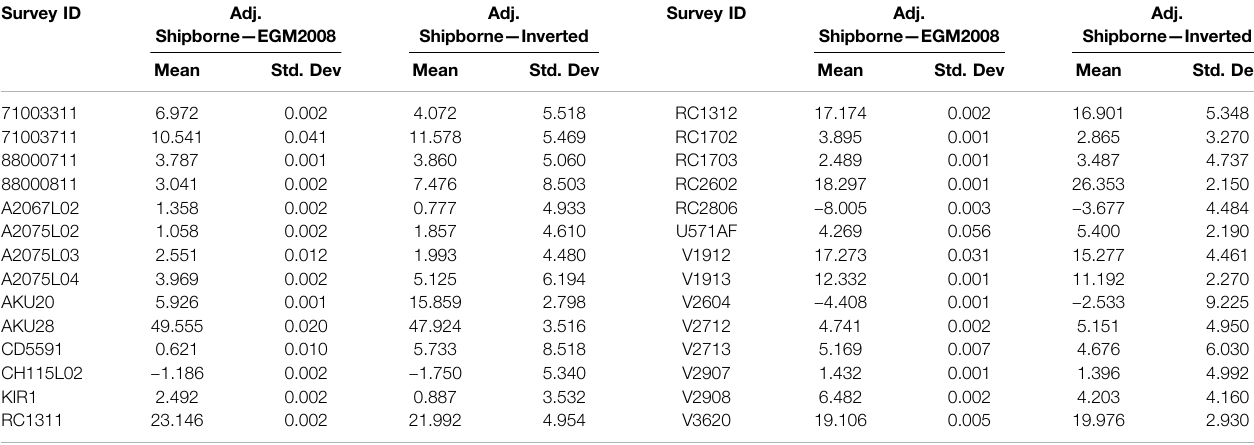
TABLE 5 | Accuracy assessment of modelled gravity anomalies per track of shipborne gravimetry (unit: mGal). Survey ID